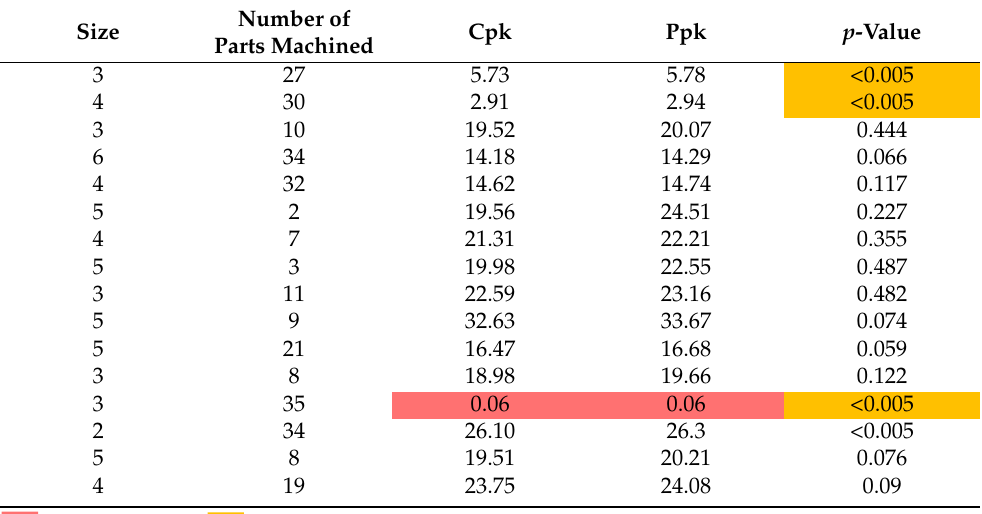
Table 5. Capability study.